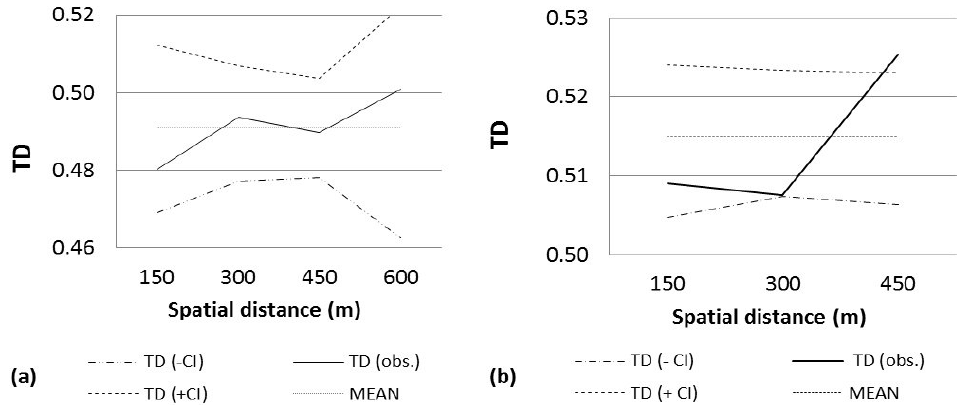
Figure 2. Analysis of fine-scale spatial genetic structure of two seed stands. Analysis of fine-scale Figure 2. Analysis of fine ‐ scale spatial genetic structure of two seed stands. Analysis of fine ‐ scale spatial genetic structure of the seed stands ( a ) La Mesa de Veracruz ( Pinus engelmannii ) and ( b ) Cócono spatial genetic structure of the seed stands ( a ) La Mesa de Veracruz ( Pinus engelmannii ) and ( b ) Cócono ( P. leiophylla ) by considering a distance class of size 150 m. Distogram calculated using the mean ( P. leiophylla ) by considering a distance class of size 150 m. Distogram calculated using the mean Tanimoto distance (TD). CI = confidence interval. Tanimoto distance (TD). CI = confidence interval. Table 4. Analysis of spatial genetic structure among seed stands of Pinus leiophylla by considering Table 3. Analysis of spatial genetic structure among P. engelmannii seed stands by considering a a distance class width of 8 km in the seed stands, 999 permutations, and a 99% confidence interval. distance class width of 160 m in the northern stands and 24 km in the southern stands, 999 The Tanimoto distance ( TD ) was calculated using Spatial Genetic Software 1.0 [5]. permutations, and a 99% confidence interval. The mean Tanimoto distance (TD) was calculated using Spatial Genetic Software 1.0 [5].